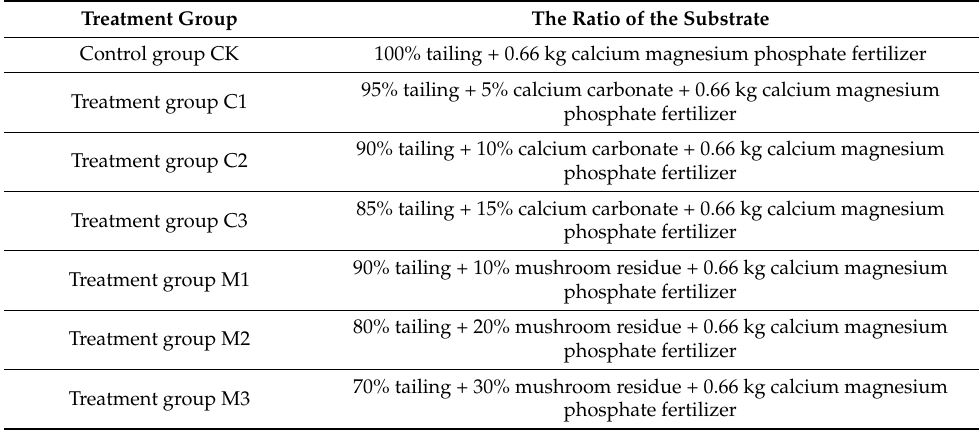
Table 1. Treatment of different substrates (weight ratio). Treatment Group The Ratio of the Substrate